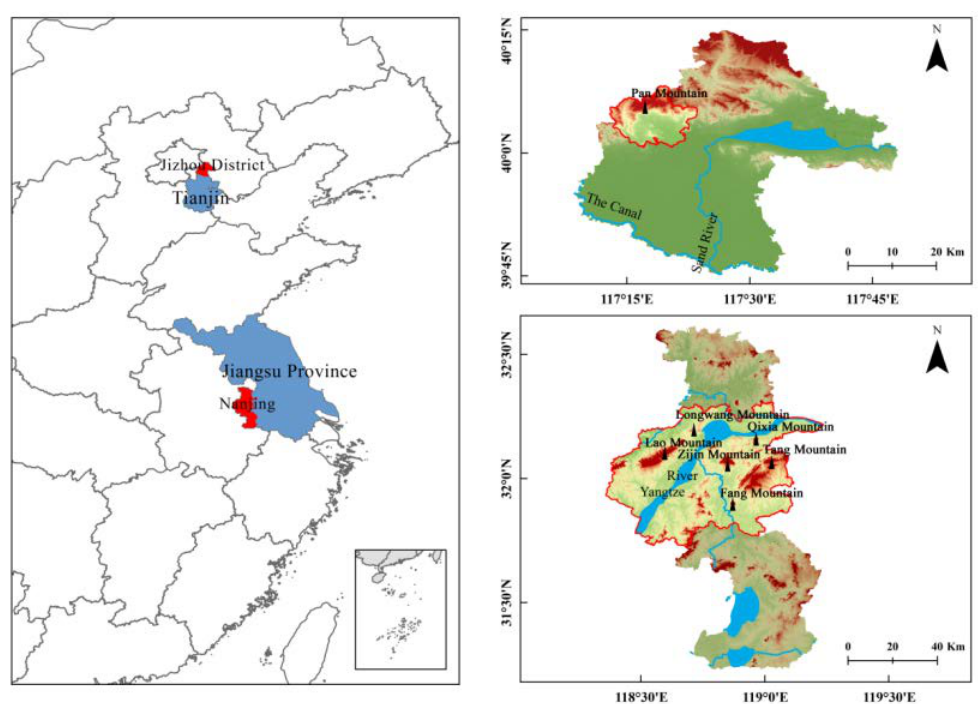
Figure 1. Seven sampling localities of S. bungii used in this study.